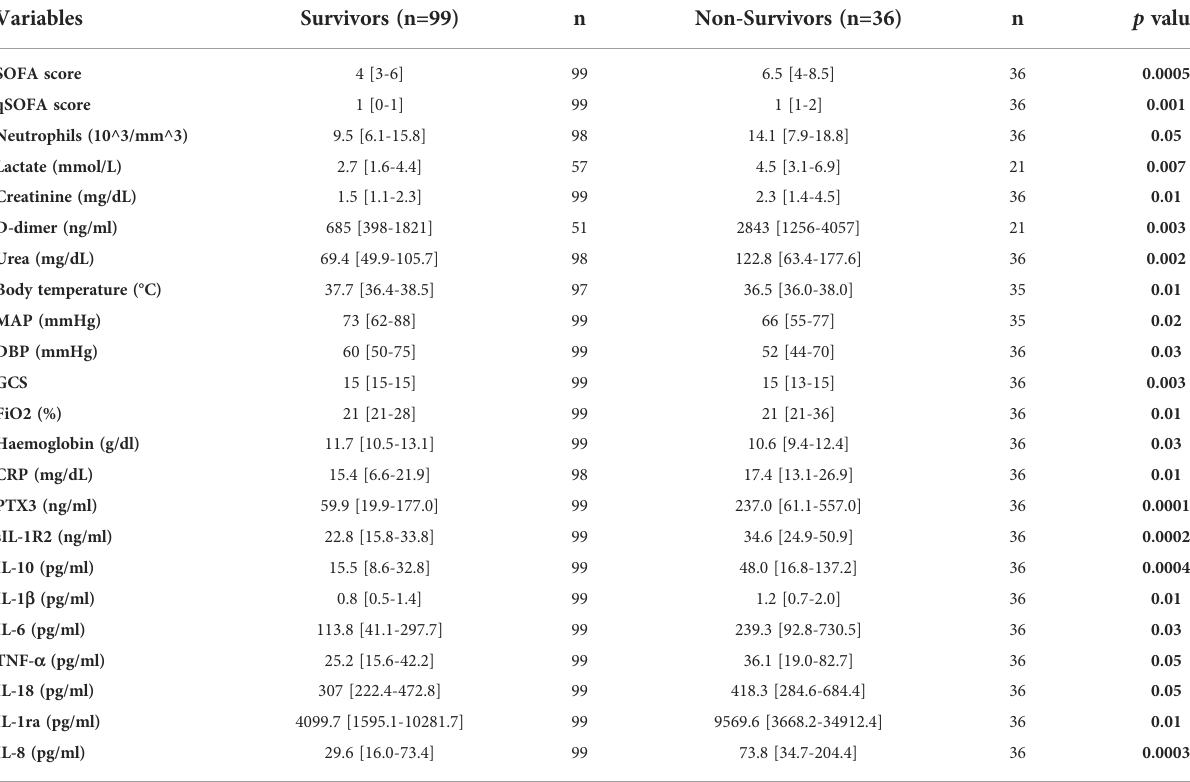
TABLE 5 Distribution of selected clinical parameters and biomarkers among survivors and non survivors in the Sepsis-3 population.